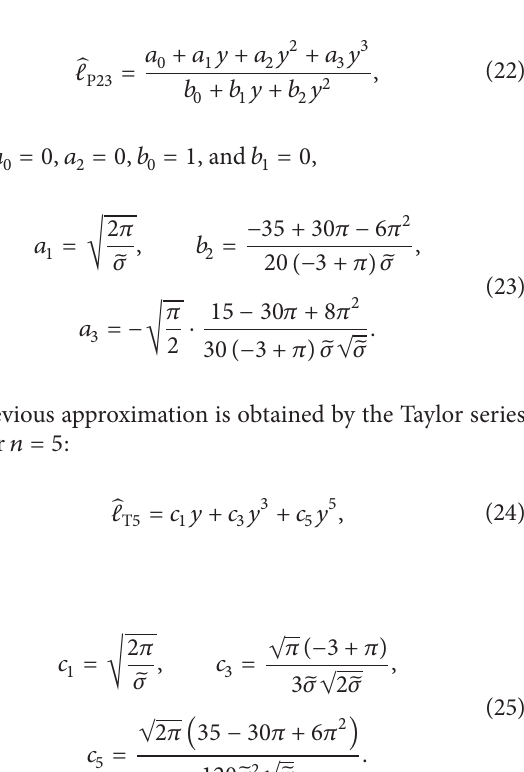
order (𝑚 󸀠 , 𝑛 󸀠 ) = (2, 3) is more accurate than Taylor series of order 𝑛 = 3 around 0 in (7) which is previously known as the best approximated one [11]. The proposed LLR